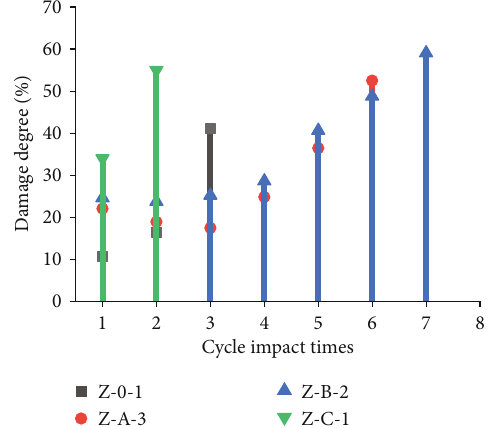
Figure 16: Relationship between di ff erent axial prestresses and damage